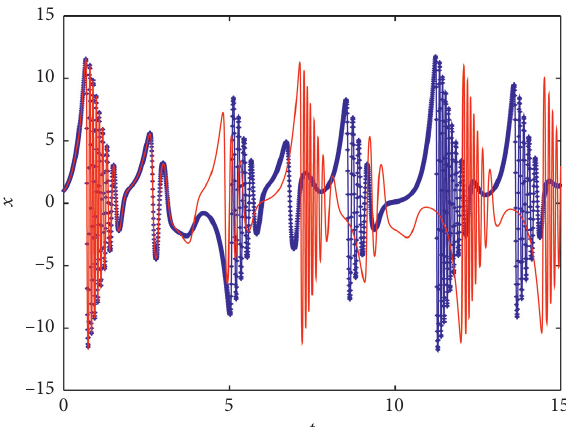
Figure 21: Sensitivity due to the variation of x ( 0 ) from x ( 0 ) � 1 to x ( 0 ) � 1 . 0001.